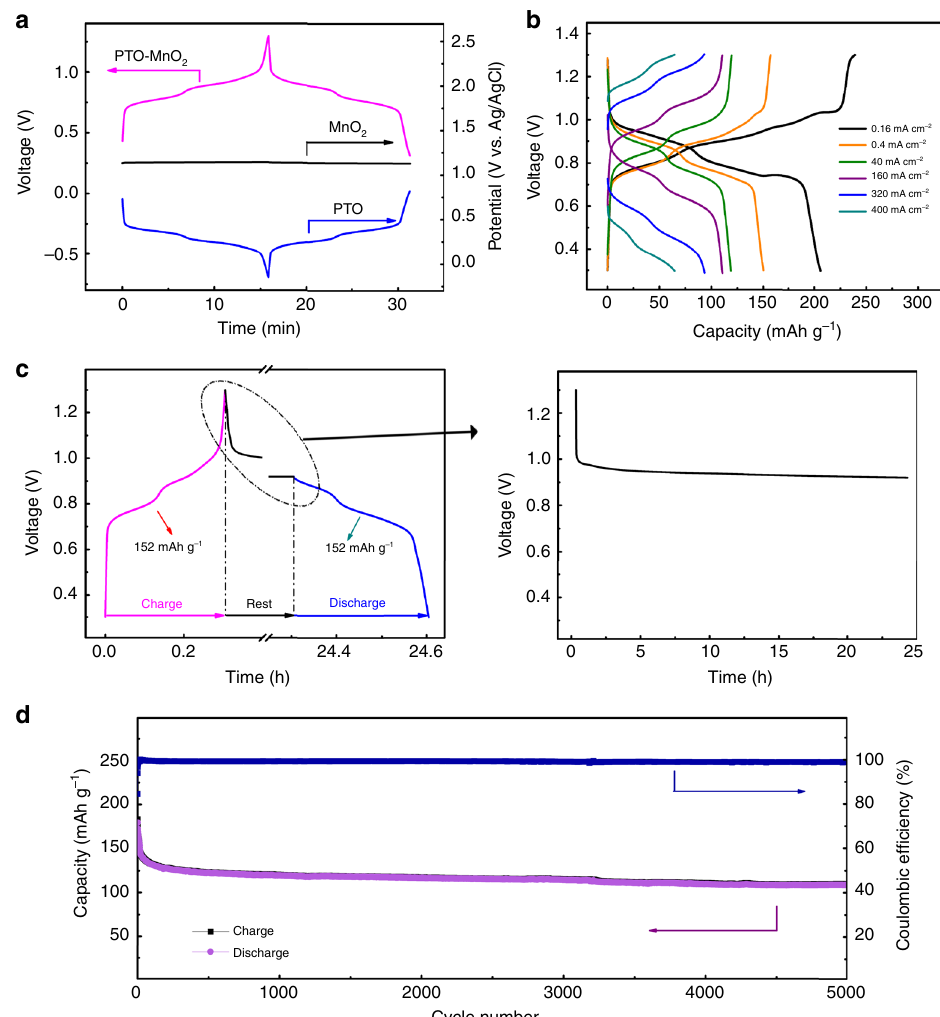
Fig. 4 Electrochemical performances and stability property study of the PTO//MnO 2 @GF prototype battery using [2 M MnSO 4 + 2 M H 2 SO 4 ] electrolyte. a Galvanostatic charge-discharge pro fi les of PTO//MnO 2 @GF full battery and synchronic typical individual charge-discharge pro fi les of PTO- anode and MnO 2 @GF-cathode, respectively, tested at a current density of 2 mA cm − 2 (2.5 C). b Rate ability described by galvanostatic charge-discharge curves at various current densities. c Electrochemical stability of the full battery surveyed by self-discharge experiments. Speci fi cally, the full battery was fully charged to 1.3 V, then fully discharged to 0 V after rest for 24 h. d Cycle stability of the full battery tested at a current density of 2 mA cm − 2 (2.5